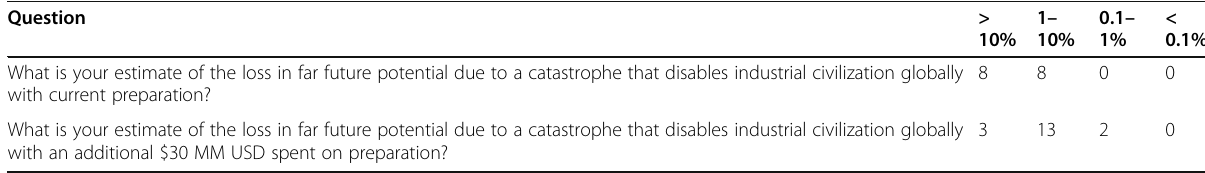
Table 6 Poll results from Effective Altruism Global